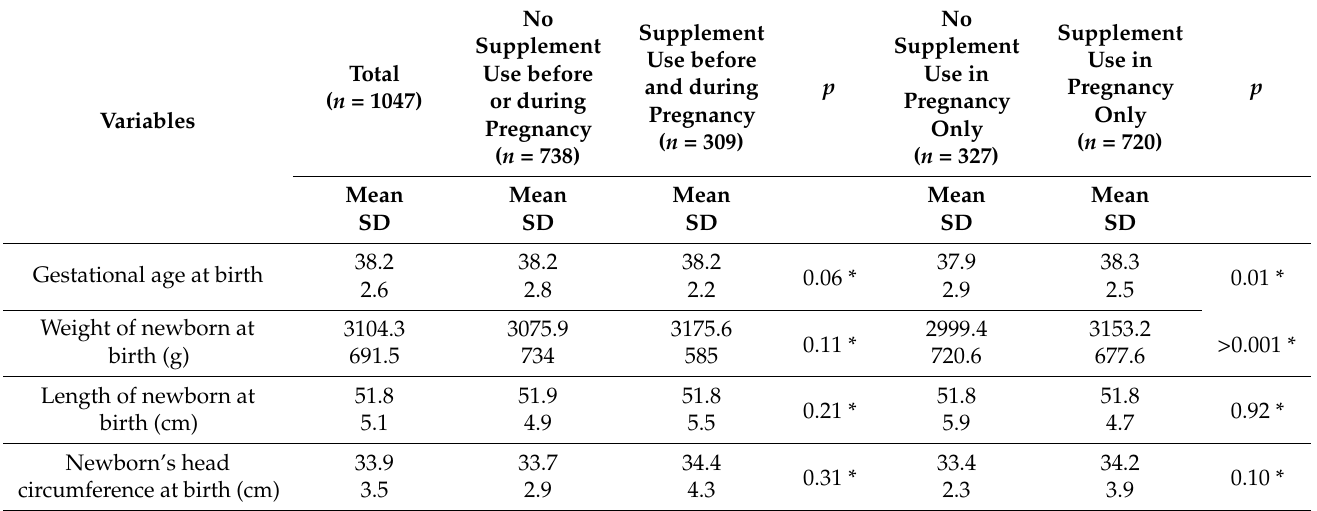
Table 3. Vitamin supplementation associated with gestational age at birth and the newborn’s anthro- pometric